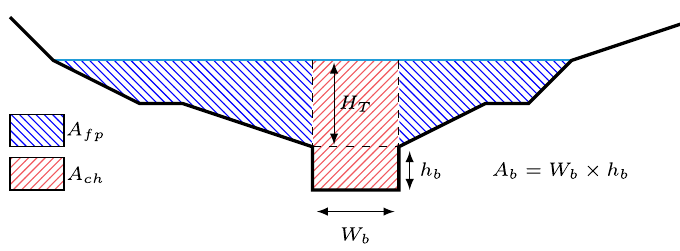
Figure 3. Typical cross section segmentation, with the cross section area of the channel ( A ch ), that of the floodplains ( A fp ) and the bankfull cross section area ( A b ) which is calculated from the average bankfull height ( h b ) and width ( W b ) computed from downstream hydraulic geometry relationships.